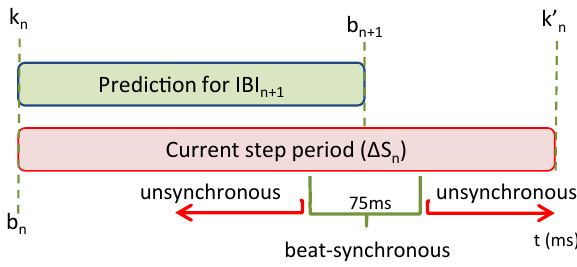
Figure 4: Online verification of the beat-synchrony be- tween the current step execution, ∆ S n , and the next IBI prediction, IBI n + 1